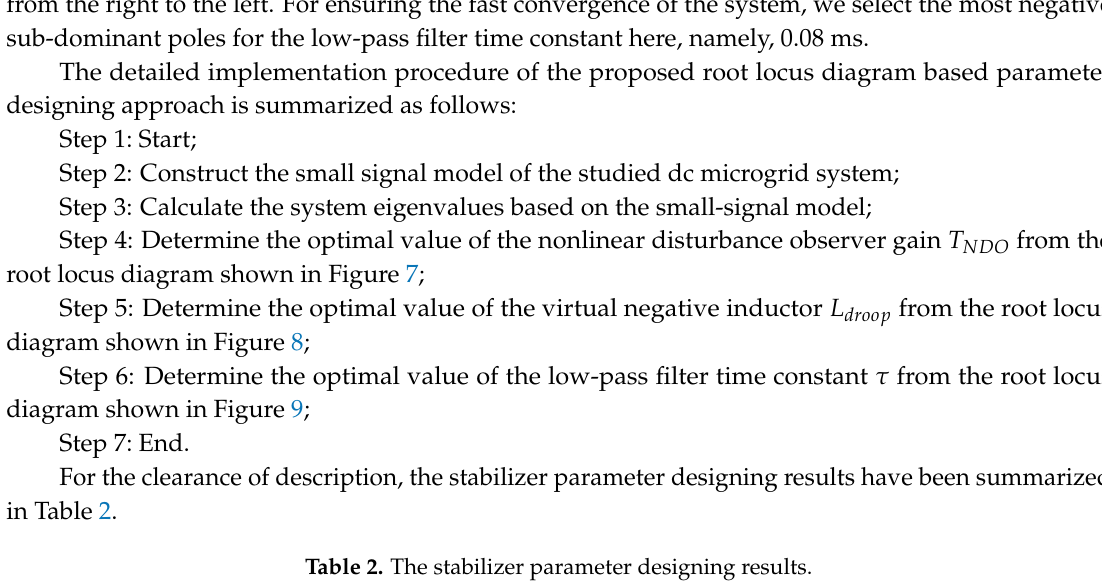
Figure 9. Root-locus diagram of the studied dc microgrid system the low-pass filter time constant varying from 0.02 ms to 0.4 ms.